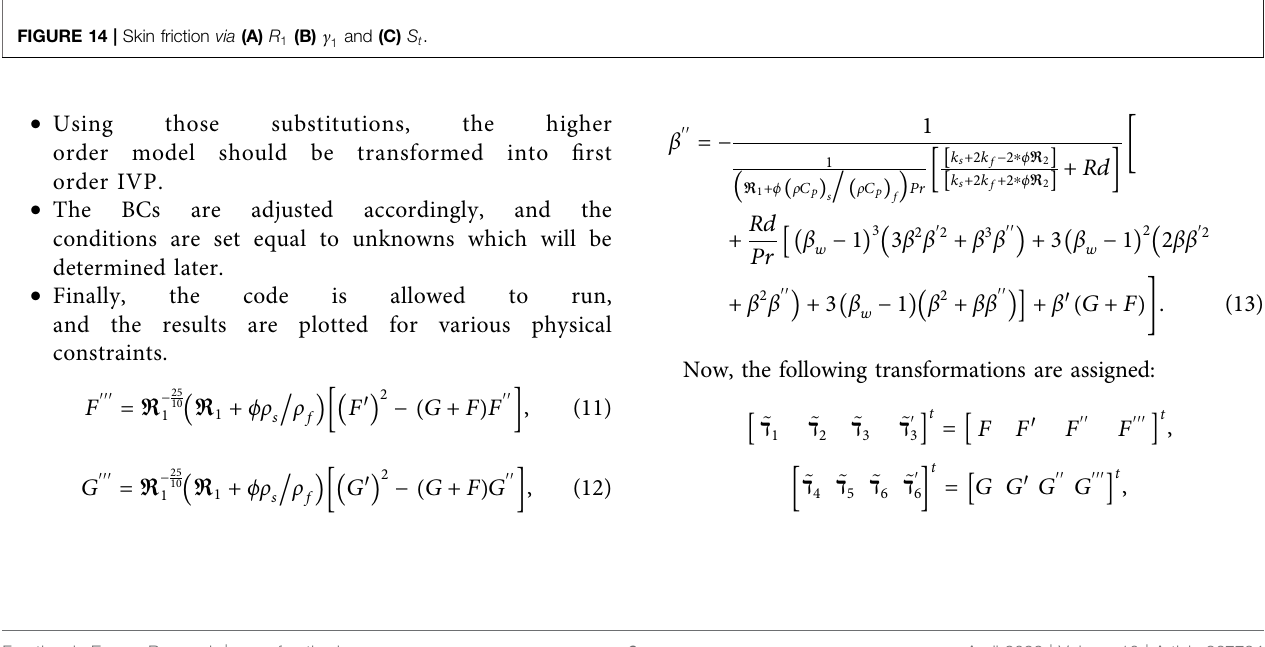
Frontiers in Energy Research |